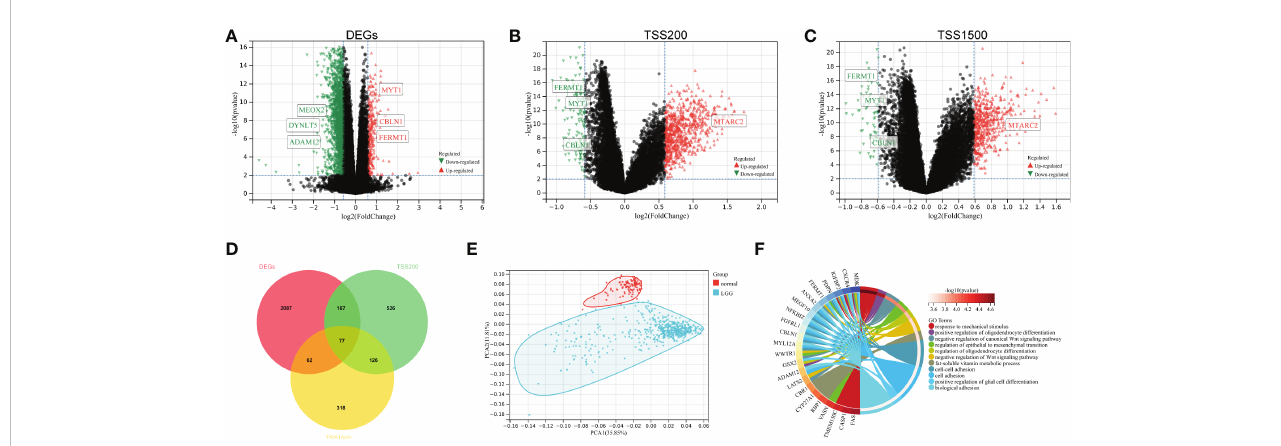
FIGURE 2 Identi fi cation and functional enrichment of DMEGs. (A) Volcano plot presenting the DEGs ( difference>1.5-fold, p-value<0.01 ) between two groups. (B) DMGs ( difference>1.5-fold, p-value<0.01 ) volcano plot of TSS200 region. (C) DMGs ( difference>1.5-fold, p-value<0.01 ) volcano plot of TSS1500 region. (D) Venn diagram exhibiting DMEGs expressed in the TCGA dataset. (E) The pro fi les of DMEGs and principal component analysis ( PCA ) between tumor and normal cortex tissues. (F) GO analysis shows signi fi cant GO terms in